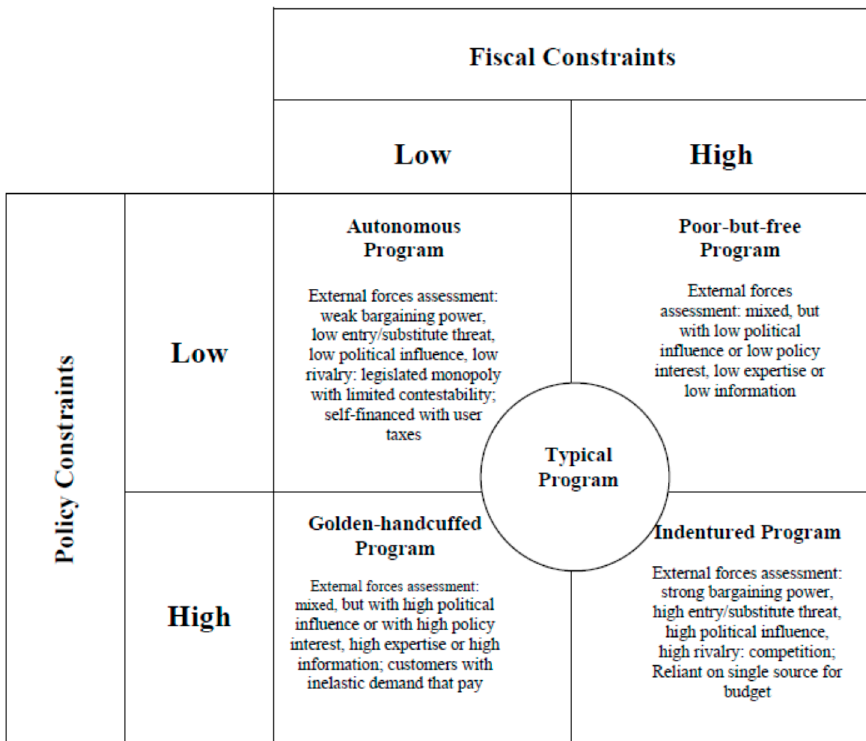
Figure 5. Typology of Program Autonomy and Different Degrees of Freedom.